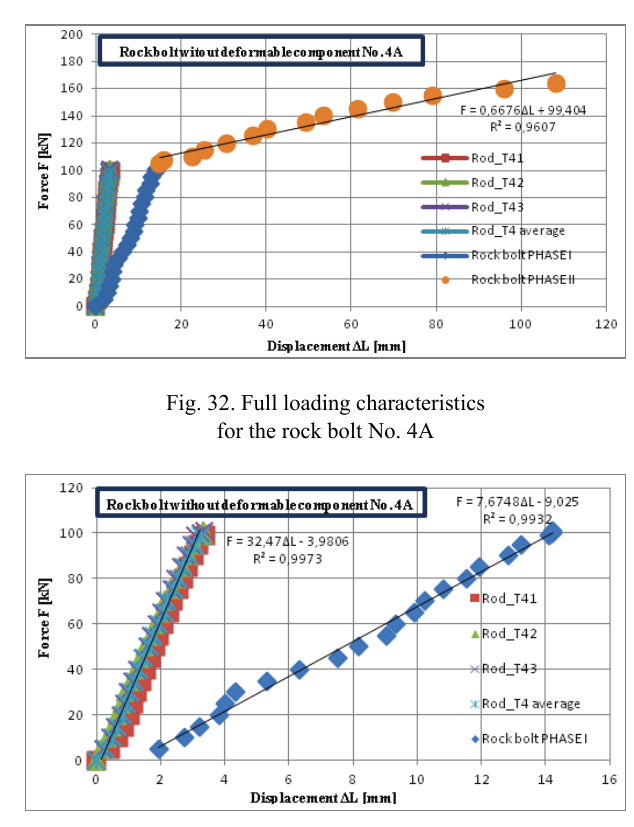
Fig. 33. Detailed loading characteristics for the components of the rock bolt support No.